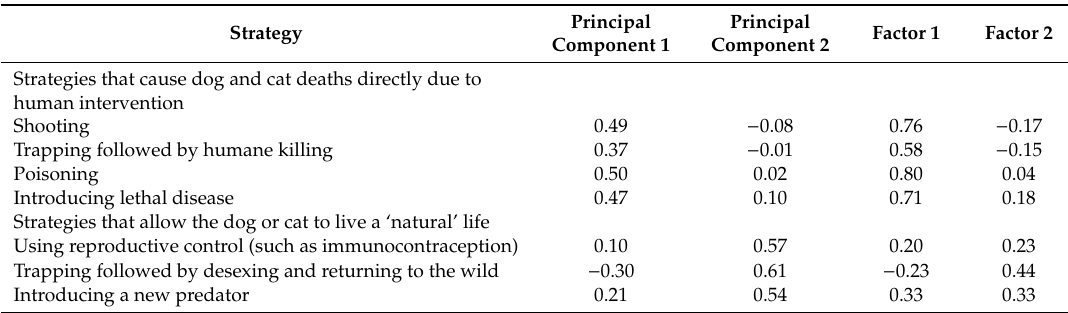
Table 5. Loadings for the first two principal components and the first two factors of respondents’ views about the acceptability of various strategies for reducing or preventing wild dog and cat predation on wildlife ( n = 527 1